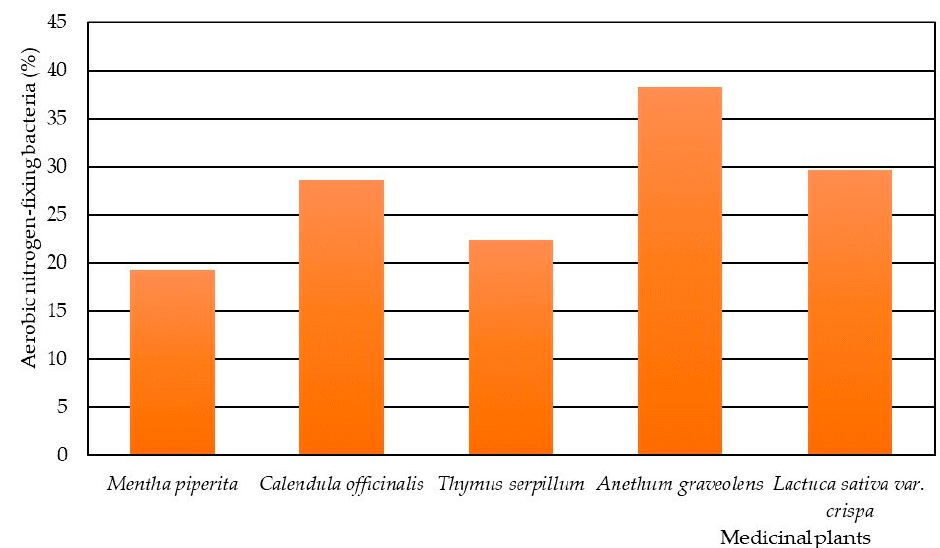
Figure 6. Aerobic nitrogen-fixing bacteria (%) in soils of agroecosystems contaminated by antibiotics. The data are statistically significant, p < 0.05, x ± SD, n = 4. Table 3. The integrity of the soil microbial community in edaphotopes of agroecosystem of medici- nal plants without antibiotic contamination.